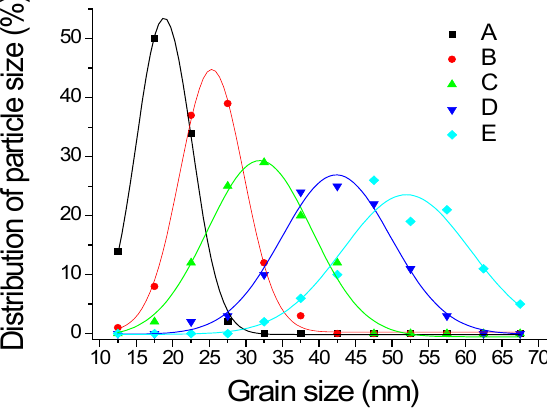
Figure 4. The grain sizes of Samples ( A – E ) are nearly Gaussian distributions. Table 2. The grain sizes and hotspots for Samples A–E. Sample